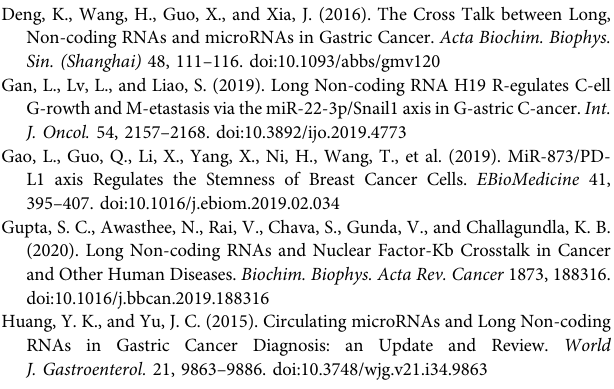
Supplementary Figure S1 | Relative expression of the mRNA levels of NF- κ B target genes NFKBIA and TNFAIP3 in AGS and MKN45 cells pretreated with H19 siRNA and stimulated with TNF- α for 30 min. (C,D) The protein level of NF- κ B in AGS and MKN45 cells pretreated with H19 siRNA and stimulated with TNF- α for 30 min. Results were expressed as mean ± SEM, and statistical analysis was performed using two-way ANOVA followed by Tukey ’ s Multiple Comparison Test. *, # p < 0.05 ( n ≥ 3). *P compared with the control group and #P compared with the TNF- α -siRNA-NC group. Supplementary Figure S2 | Serum (A) and tumor tissue (B) concentration of TNF- α in mice subcutaneously injected with AGS or MKN45 cells and treated with TP (125 μ g/kg, ip) once a day and TNF- α (10 μ g/kg, iv) once a week. (C – F) Relative mRNA expression of NF- κ B target genes (NFKBIA and TNFAIP3), H19, and miR204-5p in mice treated with TP and TNF- α . Results were expressed as mean ± SEM, and statistical analysis was performed using Two-way ANOVA followed by Tukey ’ s multiple comparison test. *, # p < 0.05 ( n ≥ 3). * p compared with the control group and #P compared with the TNF- α -treated